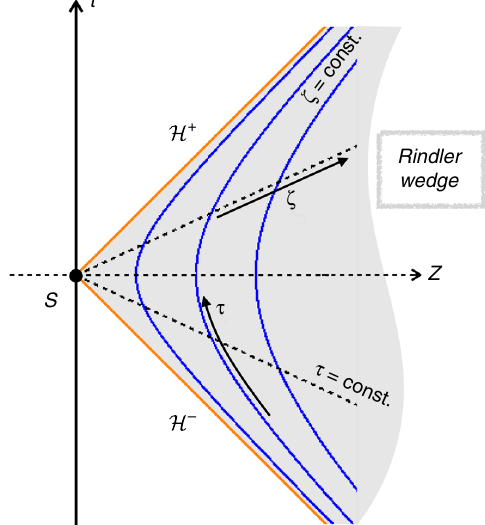
Fig. 1 Uniformly accelerated frame and the Rindler wedge. Depiction of the Minkowski spacetime region Z > | t | covered by the coordinates τ and ζ (suppressing coordinates X and Y ). This is commonly referred to as the Rindler wedge. Solid (blue) curves represent the ( ζ = constant) worldlines of uniformly-accelerated observers “ at rest ” w.r.t. each other, while dashed (black) lines represent τ = constant hypersurfaces — which encodes simultaneity according to these observers. All constant- ζ curves asymptote H þ and H − , re fl ecting that this uniformly-accelerated frame does not cover the whole spacetime. Moreover, there is a spacetime region which is causally inaccessible to observers in this frame, for whom H þ represents a (future) event